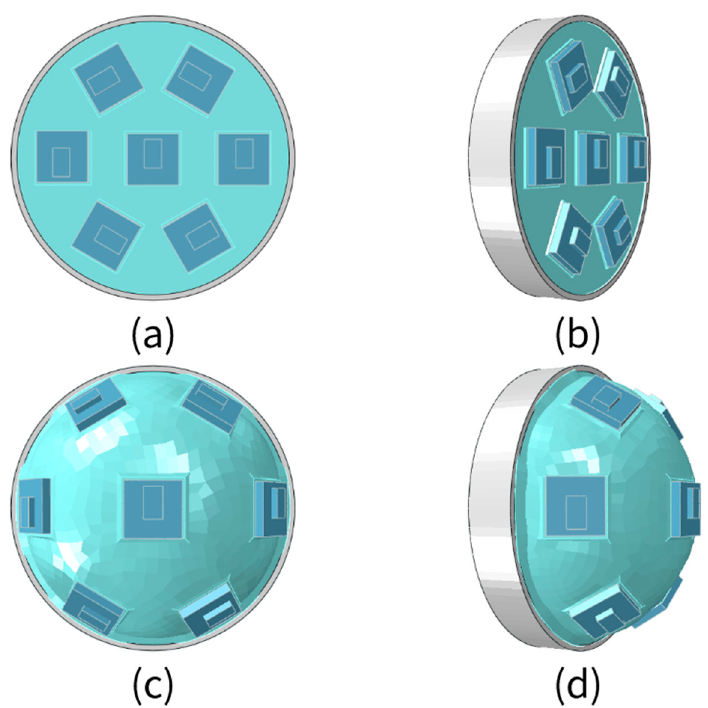
Figure 2. The soft array surface changes the basic structure of the compound eye. ( a ) Top view of unfilled gas; ( b ) Oblique view of unfilled gas; ( c ) Top view of filled gas; ( d ) Oblique view of filled